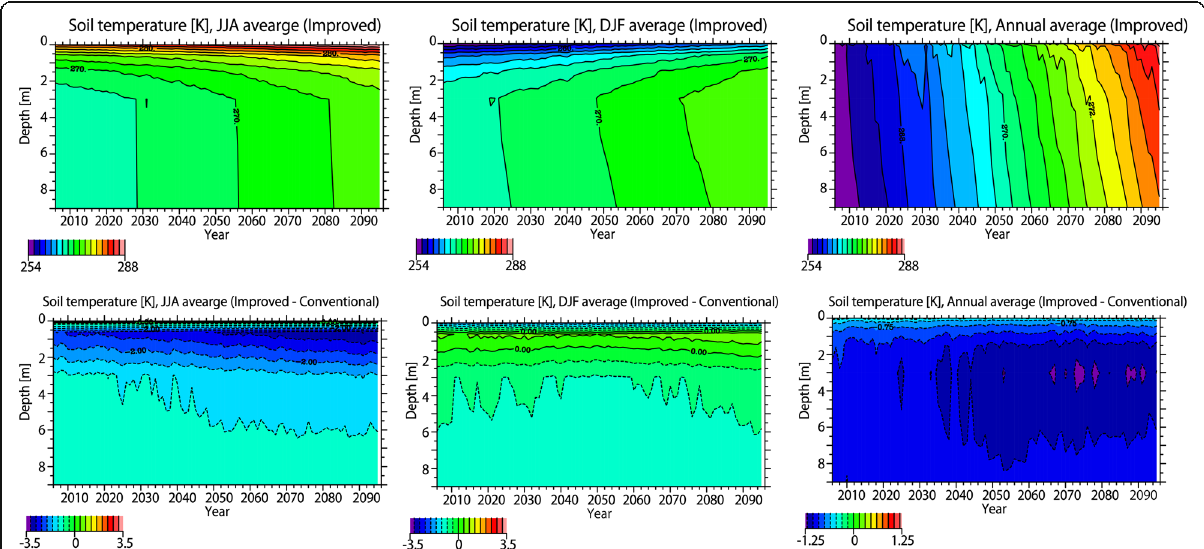
Fig. 7 Time sequence of soil temperature. Upper panels: soil temperature for JJA, DJF, and annual average in the improved scheme. Lower panels: The same as upper panels, but showing the differences between improved and conventional scheme. Vertical axis represents the soil depth [m], and the longitudinal average of the soil temperature north of 50° is shown.